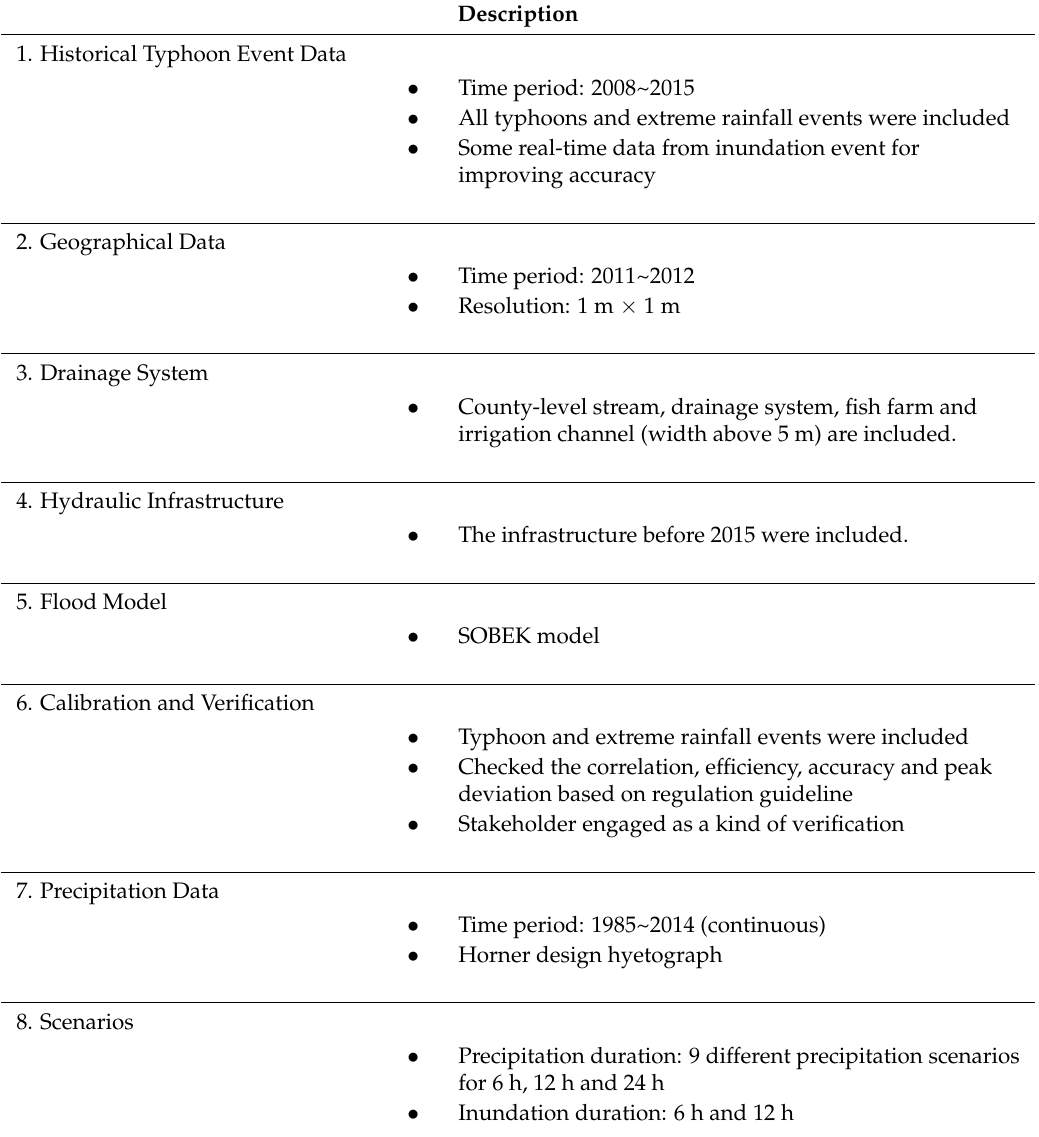
Table 2. The details of the inundation potential map from the Water Resources Agency